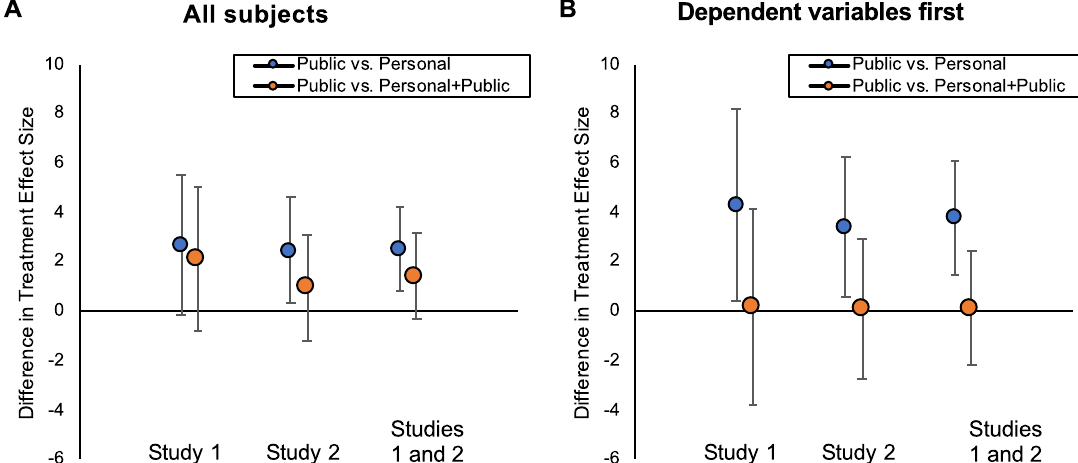
Figure 3. Relative effects of the Public treatment on prevention intentions in Studies 1 and 2. Shown are the relative effects of the Public treatment, as compared to the Personal treatment (blue dots) and Personal + Public treatment (orange dots). We plot results among all subjects ( A : Study 1 n = 742, Study 2 n = 1188, Studies 1 and 2 combined n = 1930) and subjects for whom we measured our dependent variables first ( B : Study 1 n = 389, Study 2 n = 592, Studies 1 and 2 combined n =